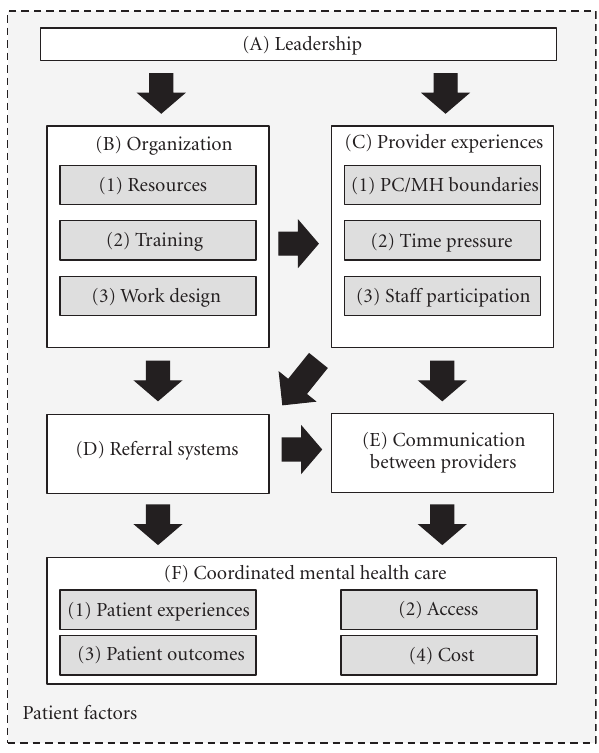
Figure 1: Theoretical framework of barriers and facilitators to locally-adapted PC/MHI